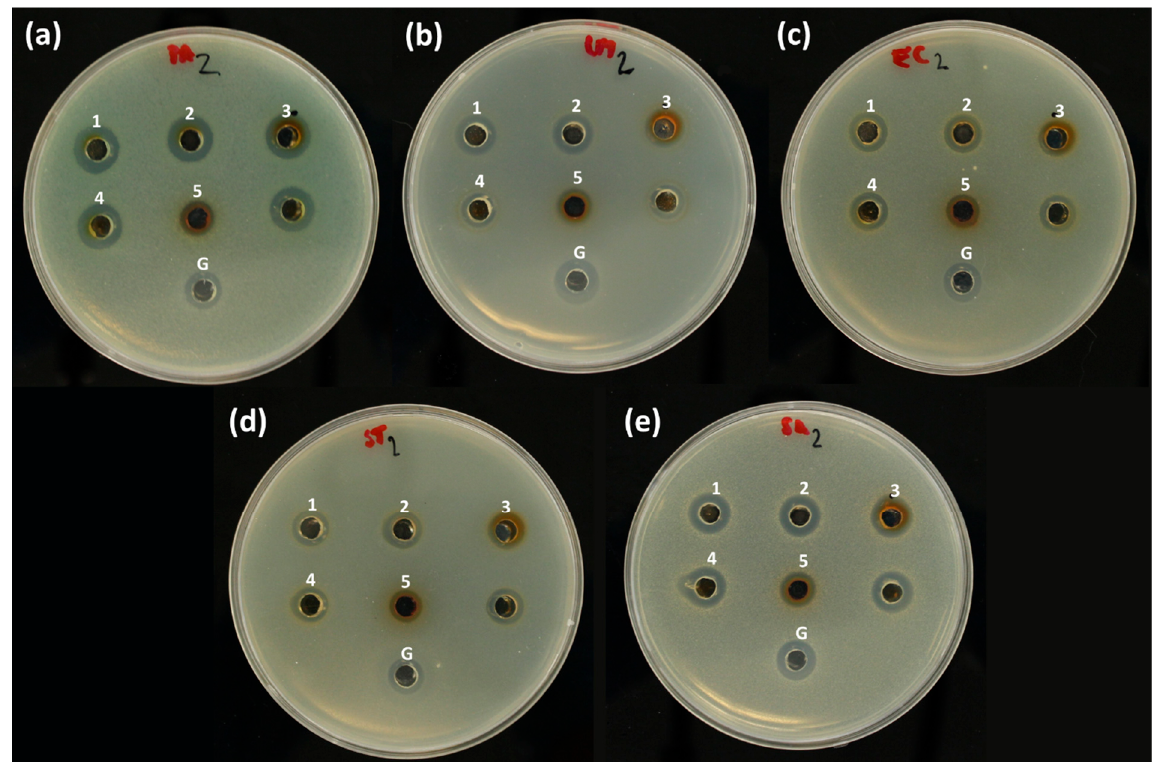
Figure 6. Petri dishes showing the antimicrobial activity of 1. BN-AgNPs, 2. BV-AgNPS, 3. LA-AgNPs, 4. CBP-AgNPs and 5. OV-AgNPs prepared from 5 mM AgNO 3 and gentamicin sulphate (G) on ( a ) P. aeruginosa , ( b ) L. monocytogenes , ( c ) E. coli , ( d ) S. enterica ser. Typhimurium and ( e ) S. aureus. Table 7. Antibacterial activity of biosynthesised